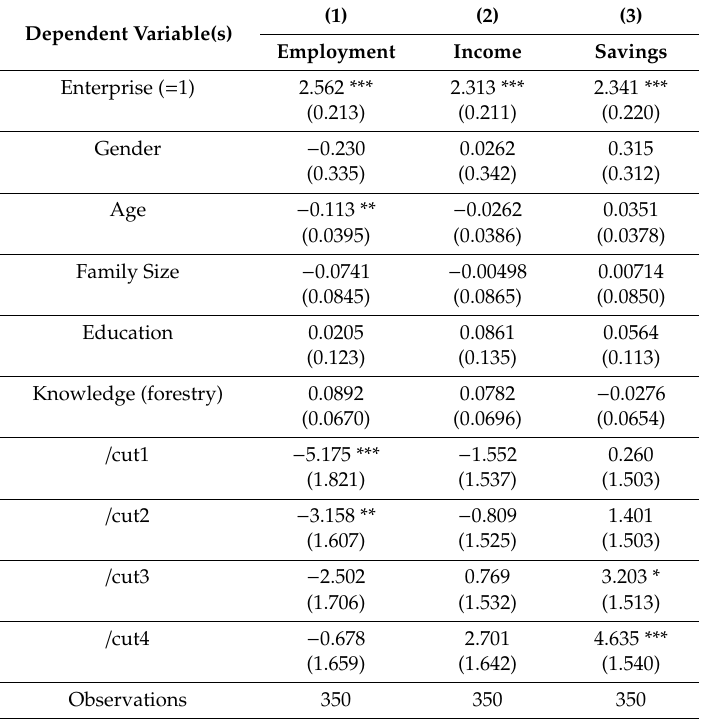
Table 6. BTAP and financial